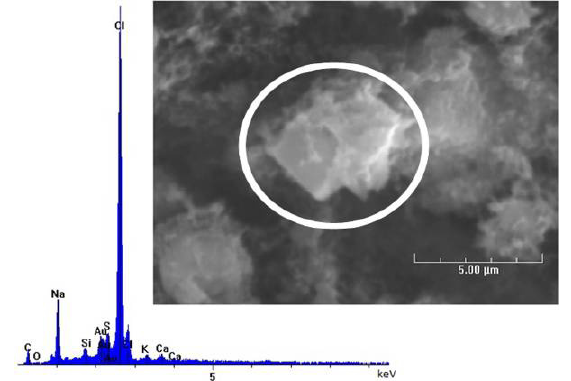
Figure 8. Dust sample from Hillingdon (collected on 06.07.2006) and EDX spectrum